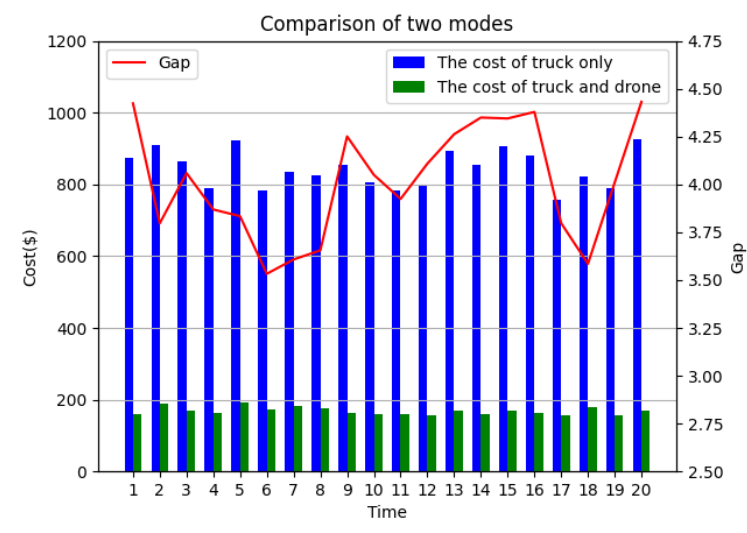
Figure 8. The comparison results of the two surveillance